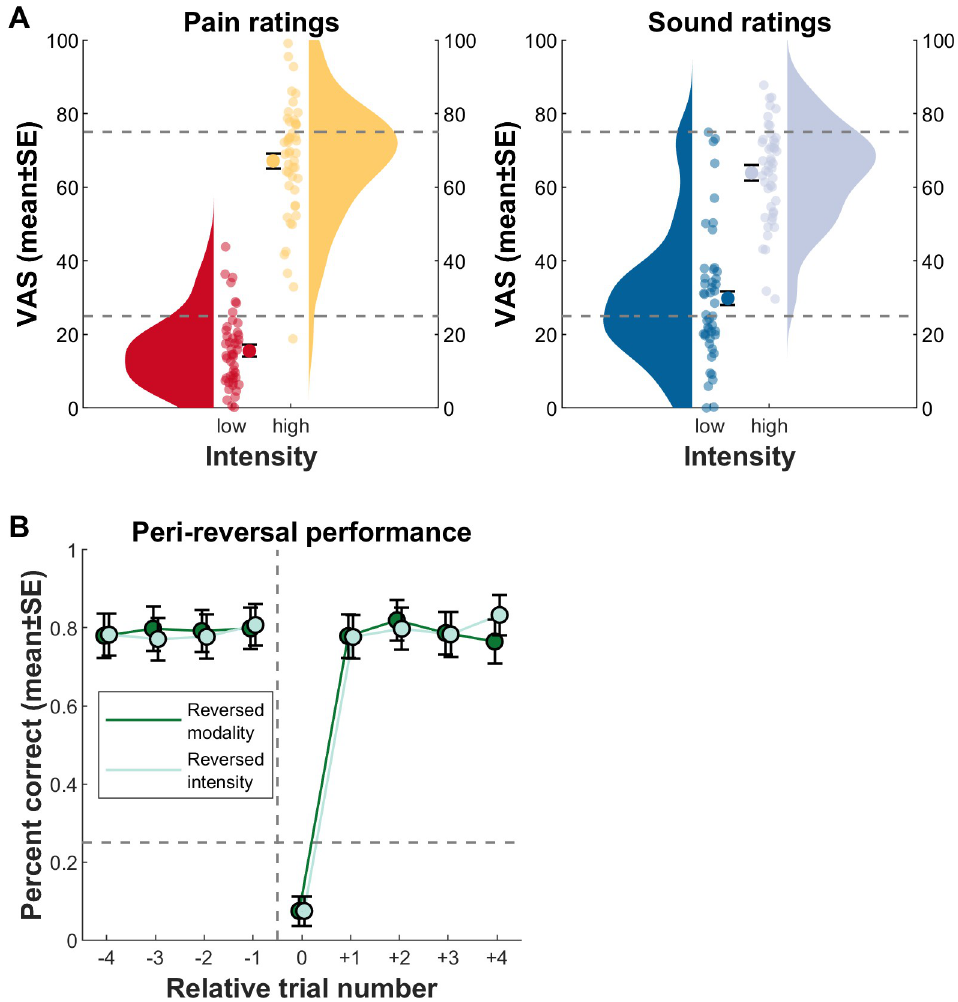
Fig 3. Behavioral results for pain ratings and performance. (A) Results for low and high unconditioned pain and sound stimuli; aggregate ratings of all pain and sound trials. Circles with error bars show the mean ± standard errors over all participant means. Participant means are displayed as smaller circles. Violin plots aggregate over participant means. The gray dashed line is the “intended” rating as per calibration (VAS 25 for low and VAS 75 for high intensities). (B) Performance pre- and postreversals, aggregated over all participants. Circles indicate the performance during (peri)reversal trials, first averaged within and then between participants (mean ± standard errors). The dashed horizontal line marks chance level (25%, i.e., 1 of 4 options). The dashed vertical line indicates contingency reversal, with relative trial number 0 as the reversal trial. Note that no difference arose between trials preceding and following modality versus intensity reversals (also see Fig 2 for aspects concerning contingency reversals). Furthermore, the steep increase in performance after trial number 0 indicates, on average, rapid learning of the new contingency. Data used to produce the figure can be found at